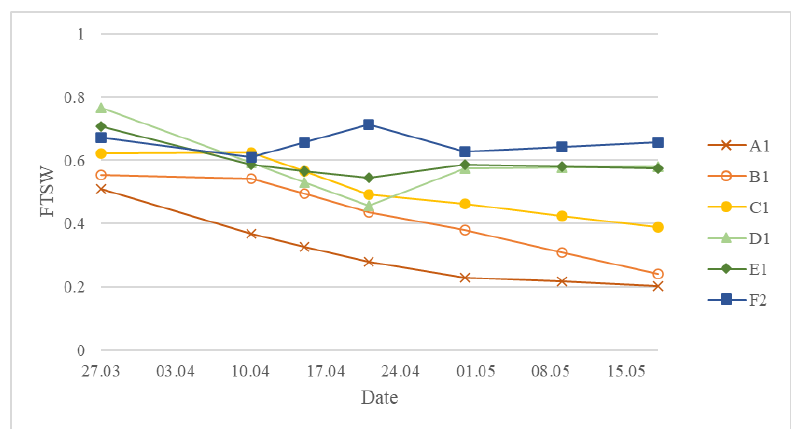
Figure 8. Seasonal change of fraction of transpirable soil water (FTSW) in March–May 2019 calculated from the volumetric soil water content measured with the neutron probe. The treatment names A–F refer to treatments from the lowest to the highest irrigation amounts, respectively, with the numbers next to the letter corresponding to the replicate number.